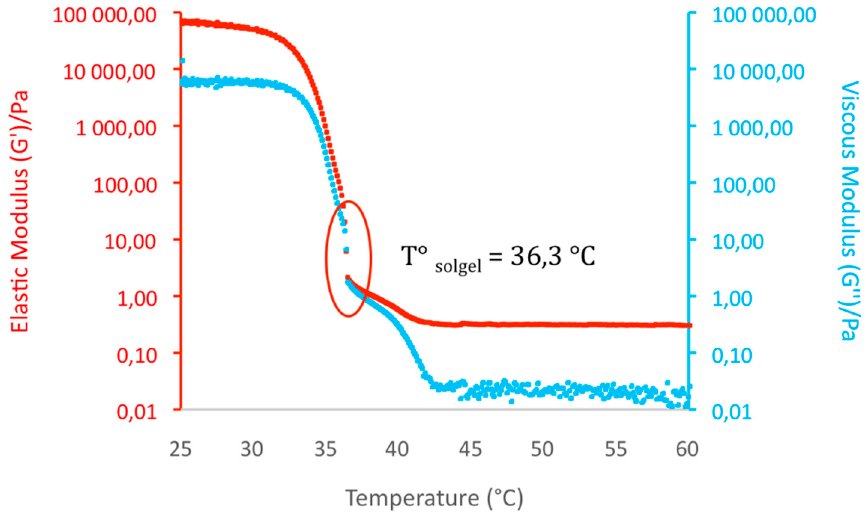
Figure 4. Gel–sol transition temperature determination for bolaamphiphile 7 hydrogel (4% ( w / v )).